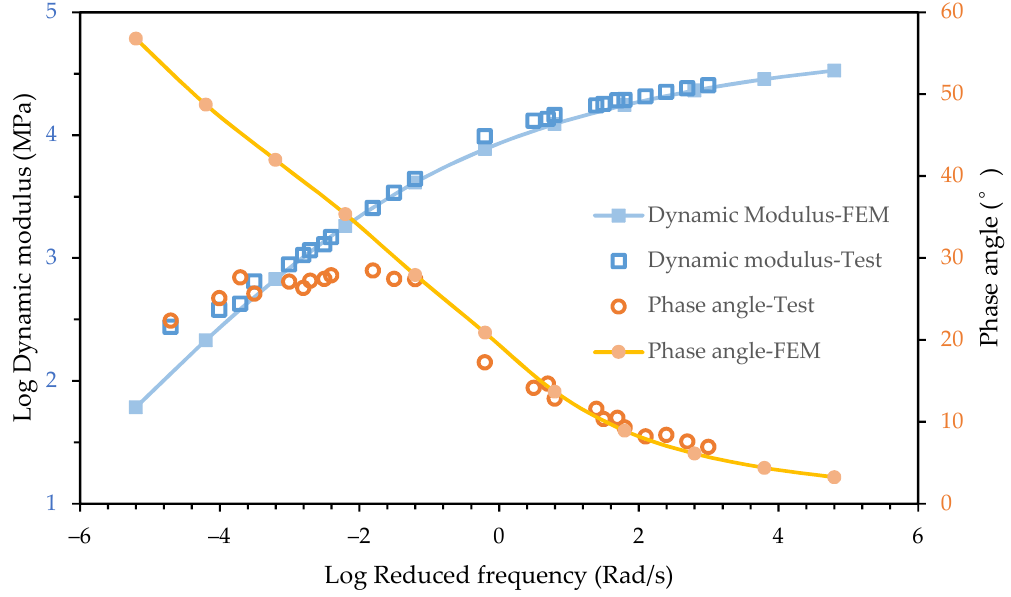
Figure 9. Comparison of simulation results and test data.